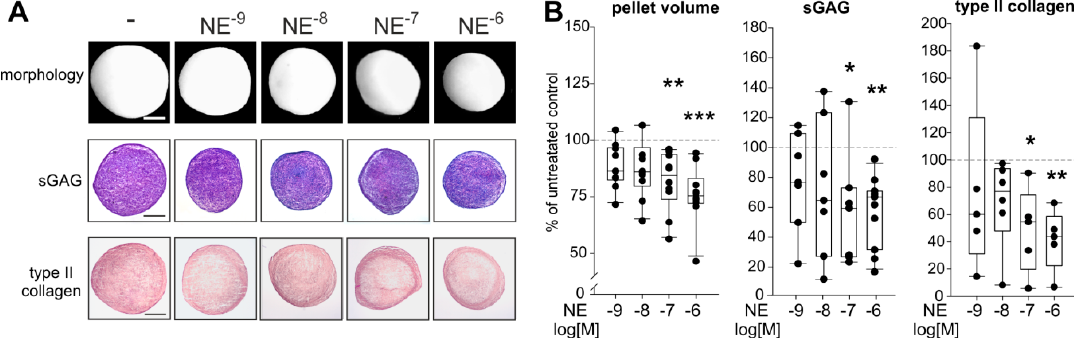
Figure 5. Effect of NE on sASC chondrogenesis. ( A ) Macroscopic, and histologic (sGAG) analysis as well as immunohistochemical type II collagen staining of untreated or NE-treated (10 − 9 –10 − 6 M) chondrogenic sASC pellets at day 21 of differentiation (bars 500 μ m). ( B ) Quantification of pellet volume and biochemical quantification of type II collagen and sGAG content of chondrogenic sASC pellets in the absence or presence of NE (10 − 9 –10 − 6 M) at day 21. Each circle shows the mean of 3 replicates per patient ( n = 6–10). Values are the percent of control (control = 100%, dashed line). Box plots are explained in legend to Figure 1. Significant p -values against untreated control are presented